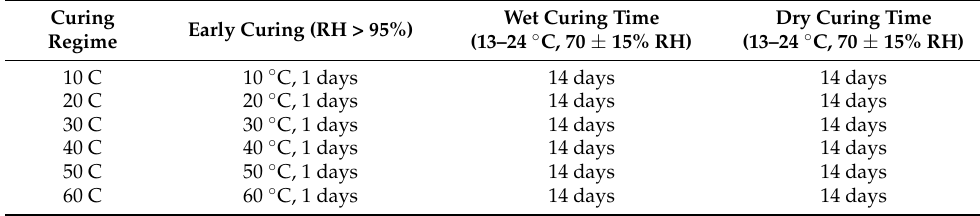
Table 7. The different curing